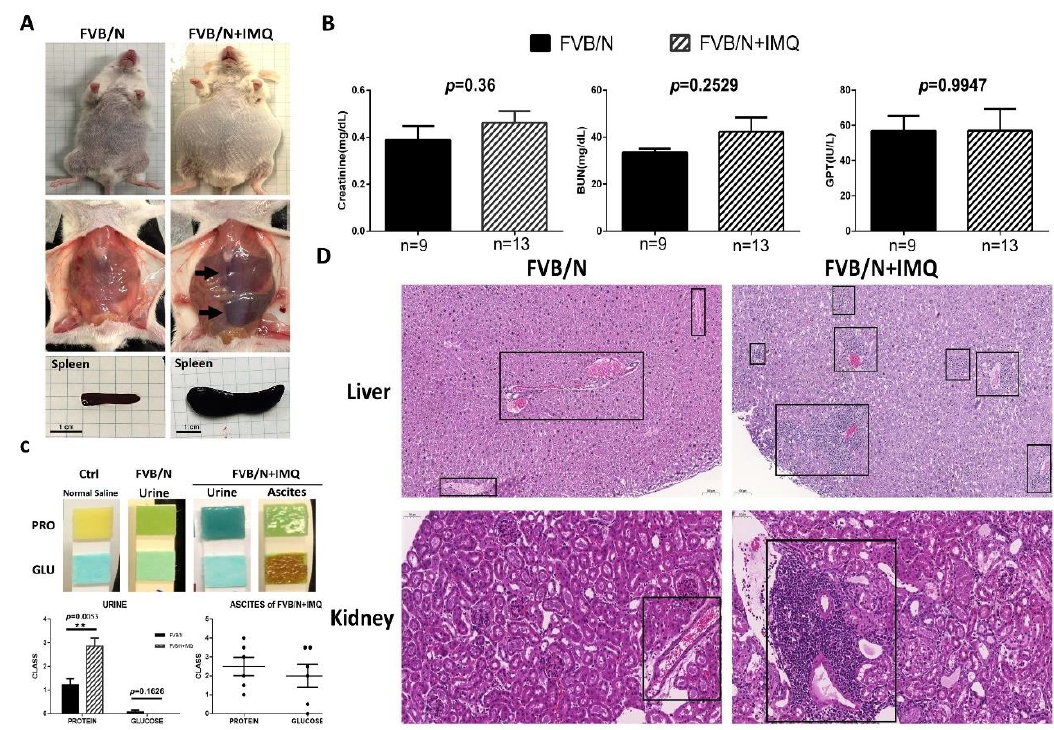
Figure 1. The animal study results of the biochemistry tests and the pathological changes in hema- toxylin and eosin staining (H&E) in the two subgroups, control (FVB/N) versus mice treated with IMQ (FVB/N + IMQ). ( A ) The general appearance of the mouse. The abdominal cavity shows hepatosplenomegaly and spleens were extracted to demonstrate the actual size differences between the two subgroups. ( B ) The biochemistry levels of kidney function (Creatinine, BUN, mg/dL) and liver function (glutamate pyruvate transaminase, GPT, IU/L) were demonstrated. No statistical differences are shown and n number is indicated in each subgroup. All p -values > 0.05. ( C ) The photos demonstrate the protein and glucose levels in each subgroup, and n number is indicated in each subgroup as shown in ( B ). The histogram is also demonstrated with a semi-quantitative method. The p -value was obtained using unpaired t -test by comparing the two subgroups and the result was 0.0053. The ** indicates that the p -value was less than 0.01. ( D ) The H&E staining over the liver and kidney tissues, left panels are from one of the three FVB/N mice, and the right panels are from one of the three FVB/N + IMQ mice. The boxed area highlights the lymphocyte infiltration over the por- tal vein area in the liver, as well as interstitial and the glomerular area in the kidney section.